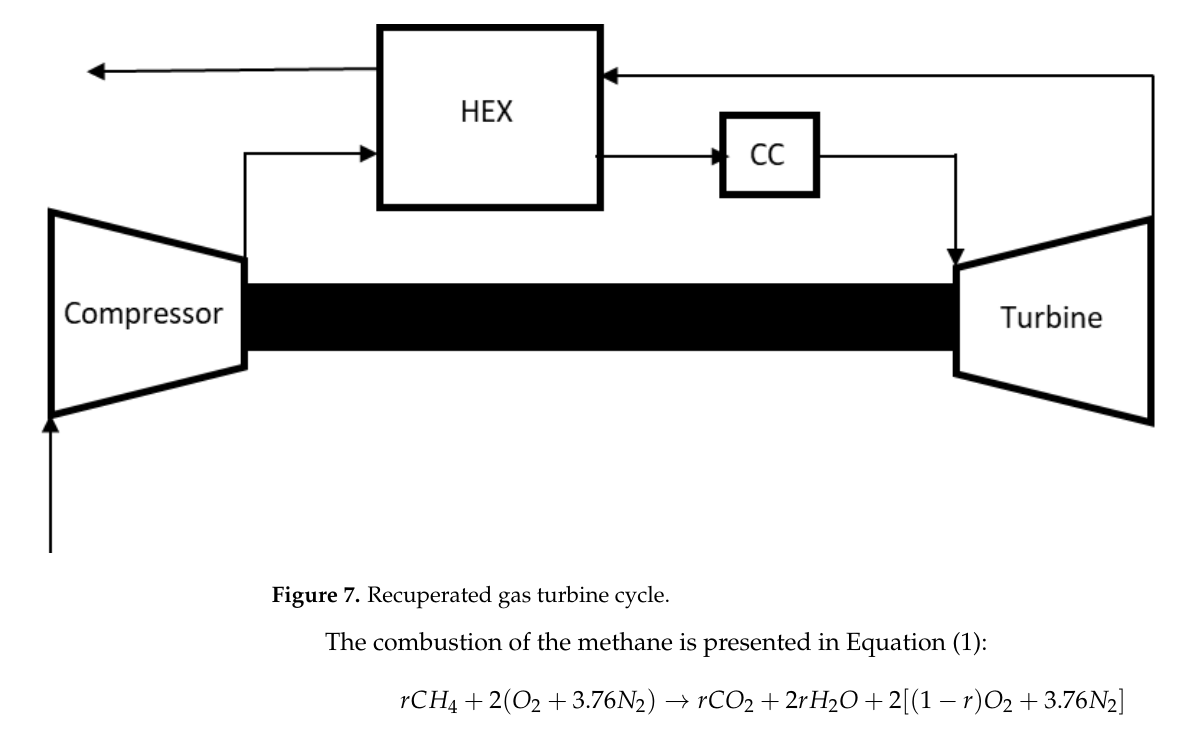
Figure 7. Recuperated gas turbine cycle.